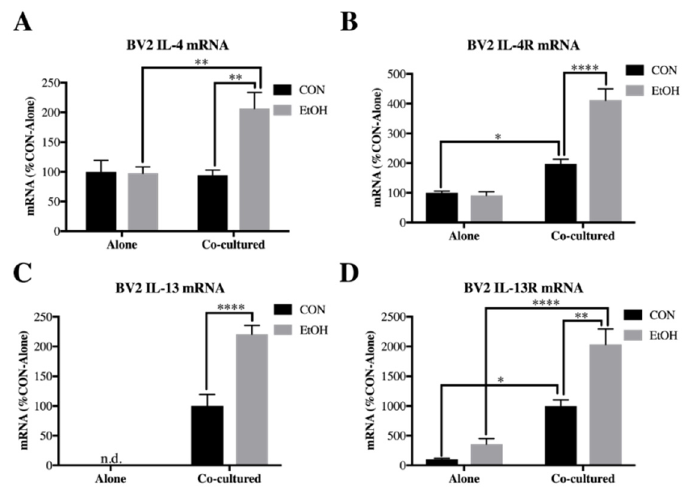
Figure 5. IL-4 and IL-13 is increased by ethanol in co-cultured BV2 microglia. BV2 microglia were treated with ethanol (EtOH, 100 mM) for 24 hours either alone or while co-cultured with SH-SY5Y. Cell lysates were examined for mRNA expression. ( A ) IL-4 expression was increased by EtOH in co-cultured BV2 (207 ± 27%). ( B ) IL-4R expression was increased by co-culture (198 ± 15%), as well as by EtOH in co-cultured BV2 (412 ± 38%). ( C ) IL-13 was not detected in BV2 alone but was increased by EtOH in co-cultured BV2 (220 ± 15%). ( D ) IL-13R expression was increased by co-culture (997 ± 107%), as well as by EtOH in co-cultured BV2 (2034 ± 261%). Data is represented as %CON (control)-Alone ± SEM, n = 5–6 per group. n.d. = not detected (>40 cycles). * p < 0.05, ** p < 0.01, **** p < 0.0001 vs. indicated group via Bonferroni’s post-hoc following 2-way ANOVA.